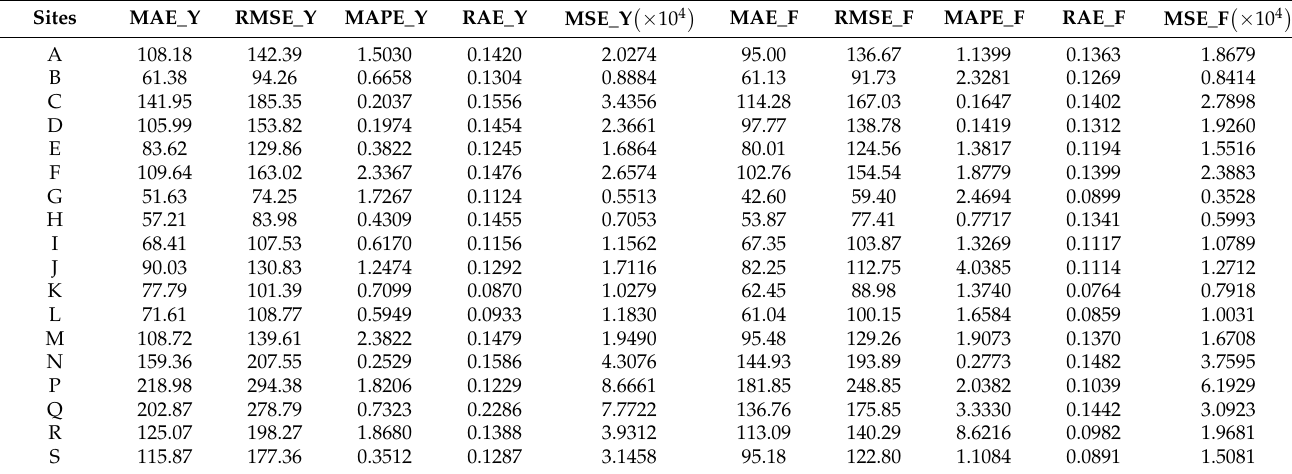
Table 9. Error analysis for the estimated normal distribution (Y) and the estimated fitness curve (F), where the first five columns describe the error in the PDF and the last five columns describe the errors in the fitness curve for the 7 GHz vertical polarization.